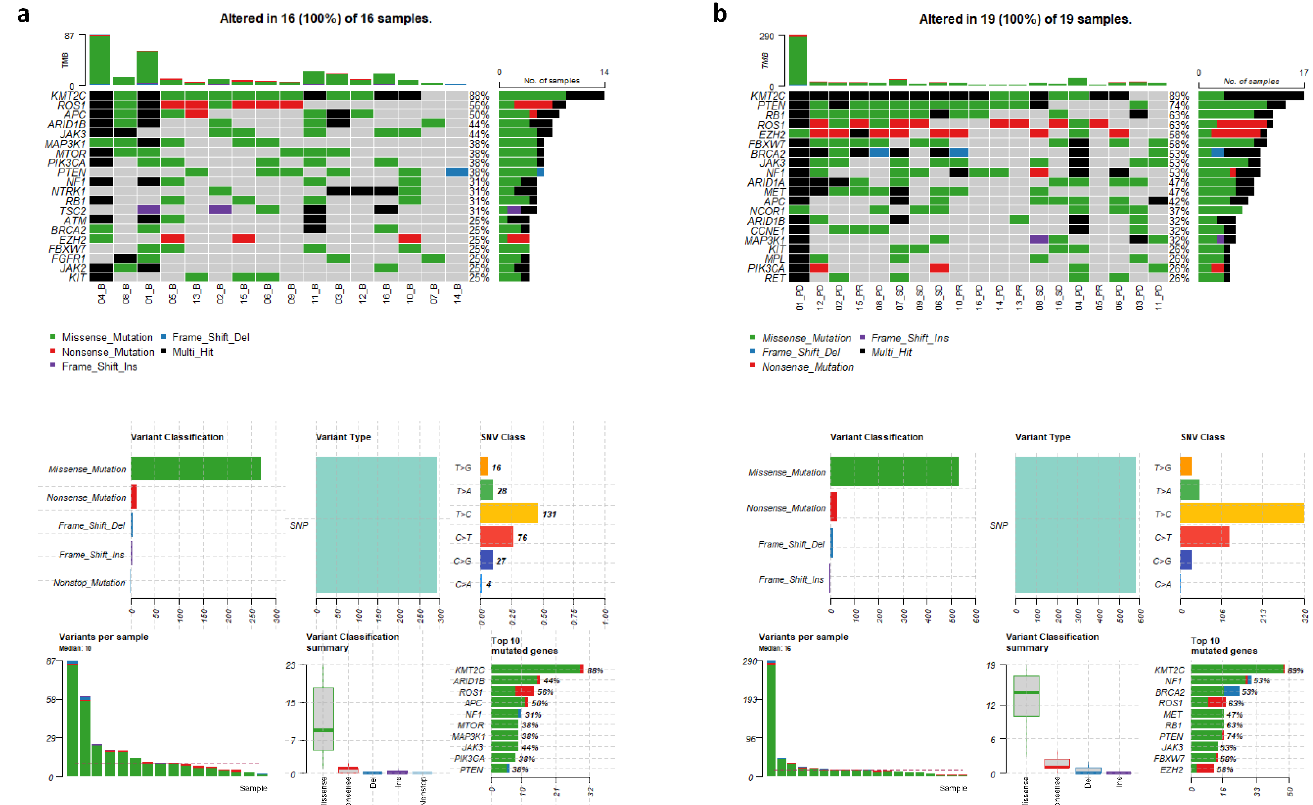
Figure 1. The top 20 most frequently mutated genes in individual metastatic breast cancer patients and summary of mutational features for blood samples collected at baseline ( a ) and follow-up ( b